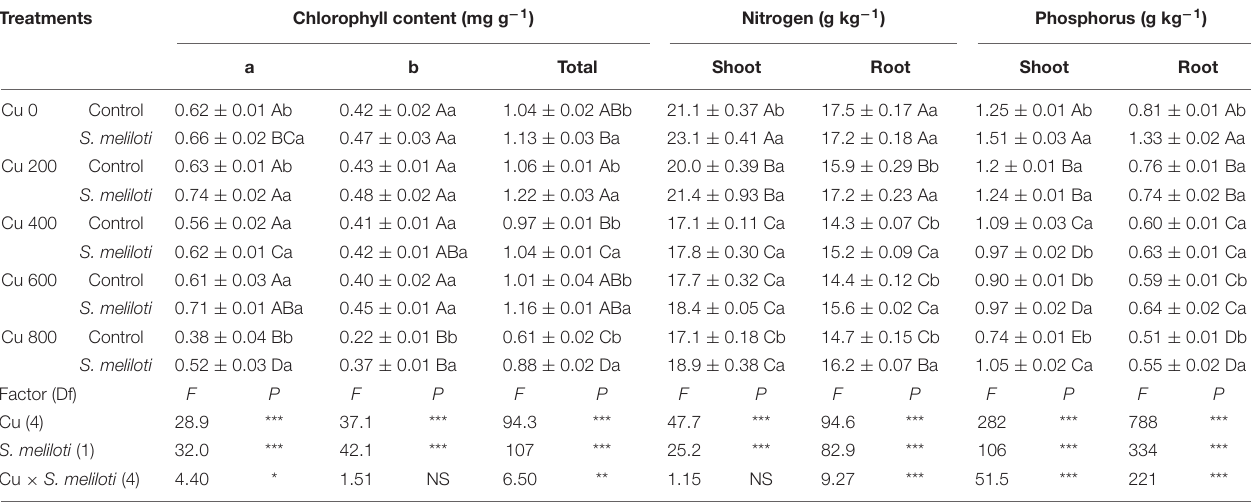
The capitalized letters indicate significant differences between different Cu concentrations, whereas the lower-case letters indicate significant differences between non- inoculated and inoculated alfalfa under the same Cu concentration condition (P < 0.05). Each value represents the mean ± SE (n = 3). ∗∗∗ P < 0.001; ∗∗ P < 0.01; ∗ P < 0.05; NS, no significant. TABLE 2 | Cu concentrations and the total uptake of Cu in alfalfa tissue. Treatments